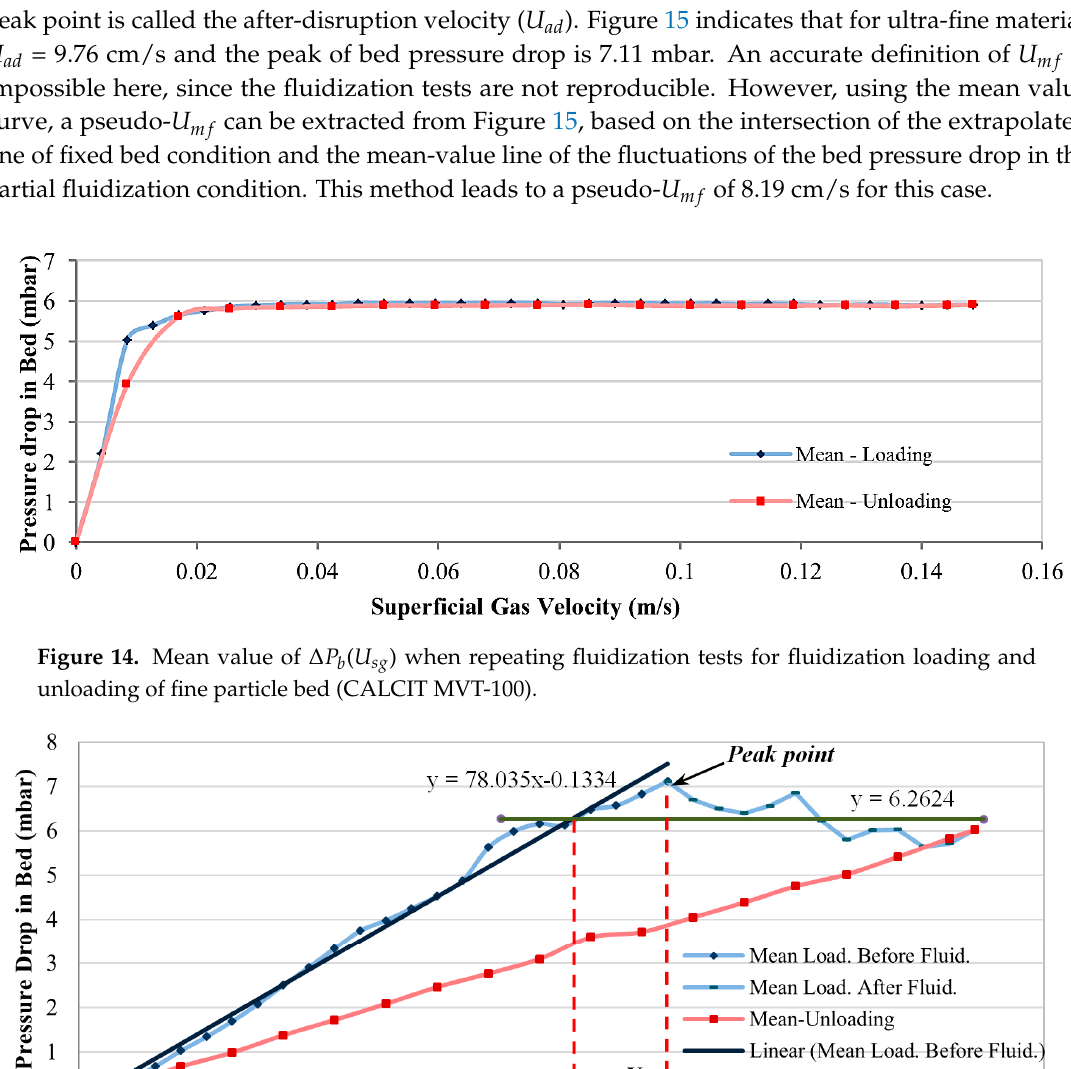
(cid:0) (cid:1) Figure 15. Mean value of ∆𝑃 (cid:3029) ( 𝑈 (cid:3046)(cid:3034) ) when repeating fluidization tests for fluidization loading and U sg Figure 15. Mean value of ( ∆ P b when repeating fluidization tests for fluidization loading and